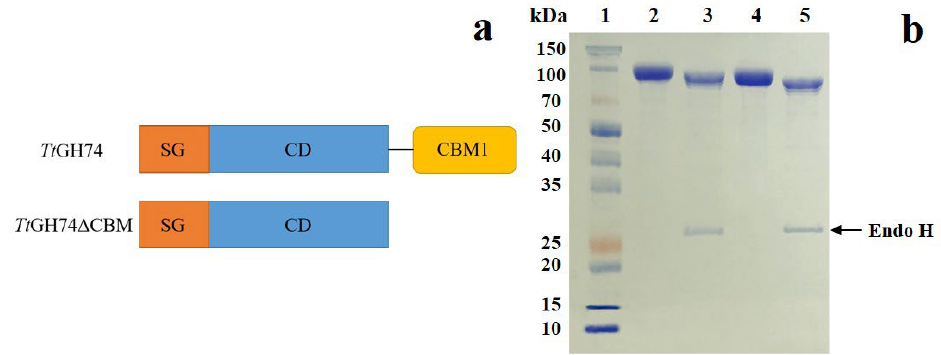
Figure 1. ( a ): The modularity of Tt GH74 and Tt GH74ΔCBM. SG, signal sequence; CD, catalytic domain module; CBM1, CBM1 module. ( b ): SDS-PAGE analysis of the purified Tt GH74 and Tt GH74ΔCBM and endo H -treated Tt GH74 and Tt GH74ΔCBM. Lane 1, molecular mass marker; Lane 2, Tt GH74; Lane 3, endo H-treated Tt GH74; Lane 4, Tt GH74ΔCBM; and Lane 5, endo H -treated Tt GH74ΔCBM.